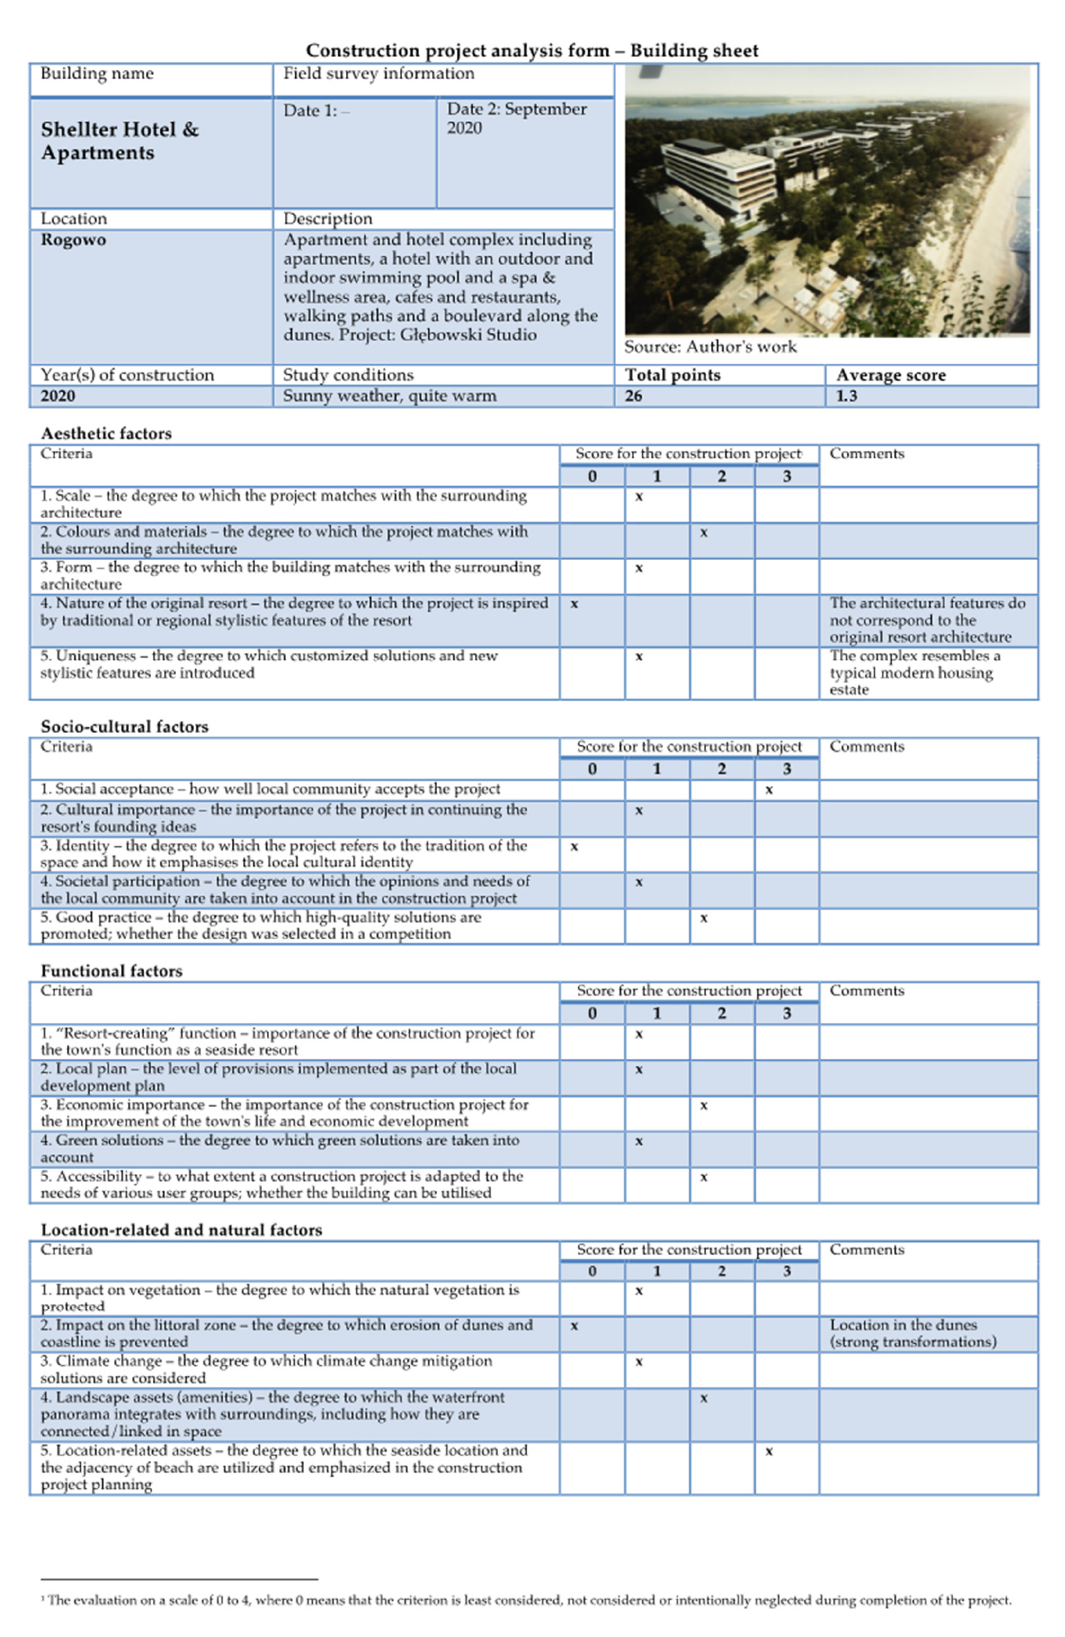
Figure A10 . Shelter Hotel & Apartments in Rogowo. Building sheet. Figure A10. Shelter Hotel & Apartments in Rogowo. Building